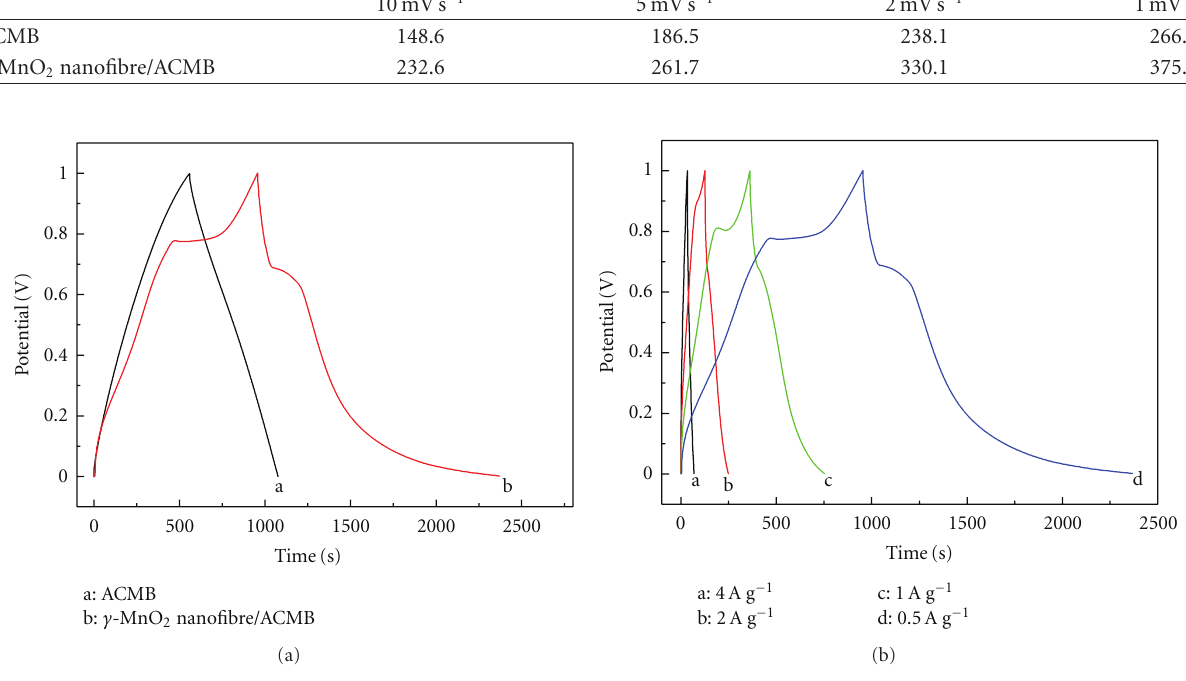
Figure 4: Charge/discharge curves of (a) ACMB and γ -MnO 2 nanofibre/ACMB composite at a current density of 0.5 A g − 1 and (b) γ -MnO 2 nanofibre/ACMB electrode at di ff erent current densities.